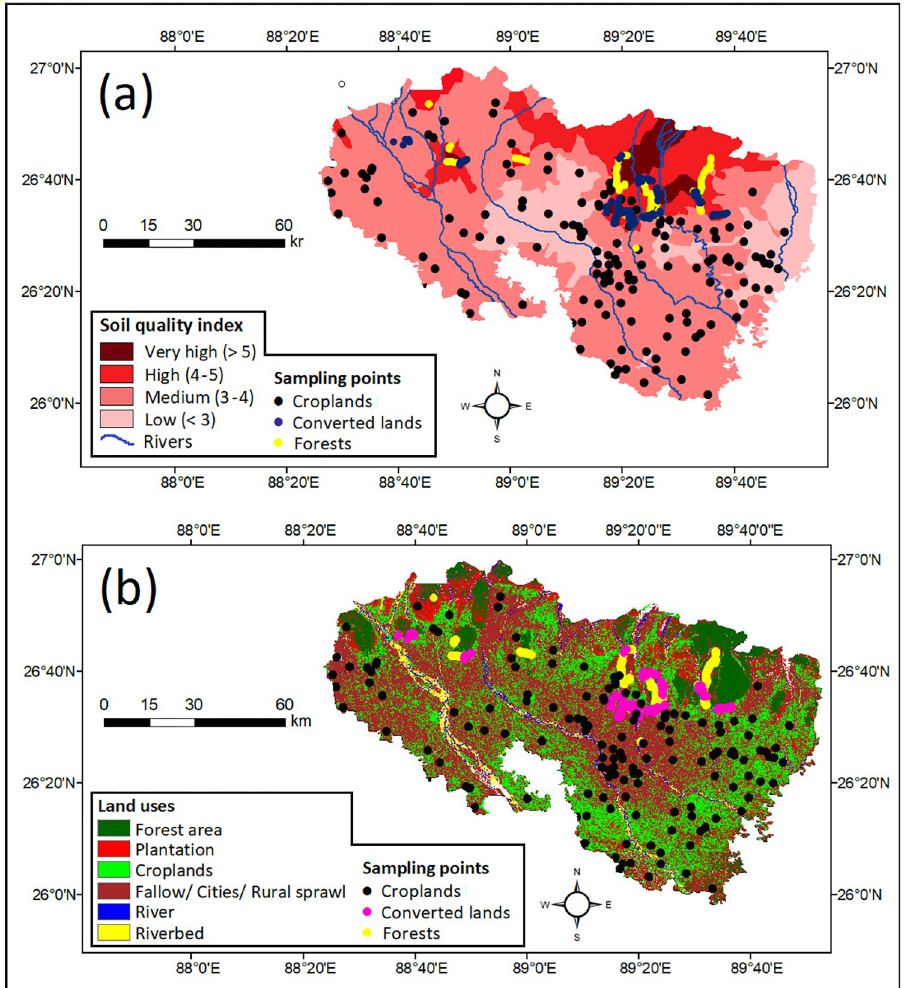
Fig 5. Comparative maps of soil quality index and land uses of the study